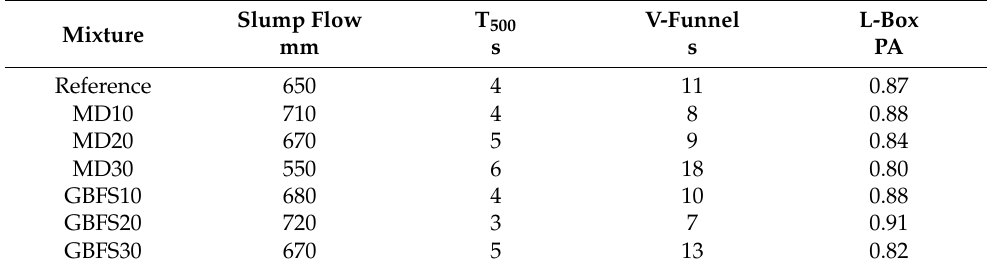
Table 4. Workability test results of the SCC mixtures.